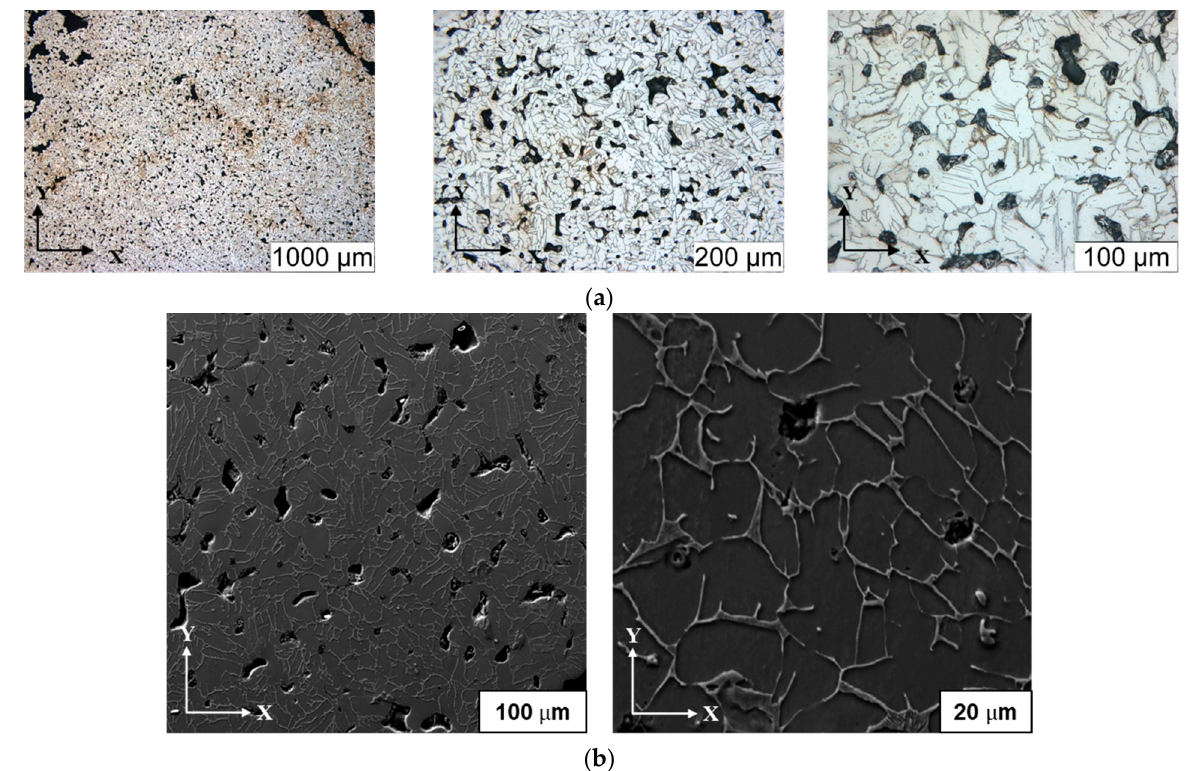
Figure 10. ( a ) Optical microscopy (etched polished condition); ( b ) SEM (etched polished condition).